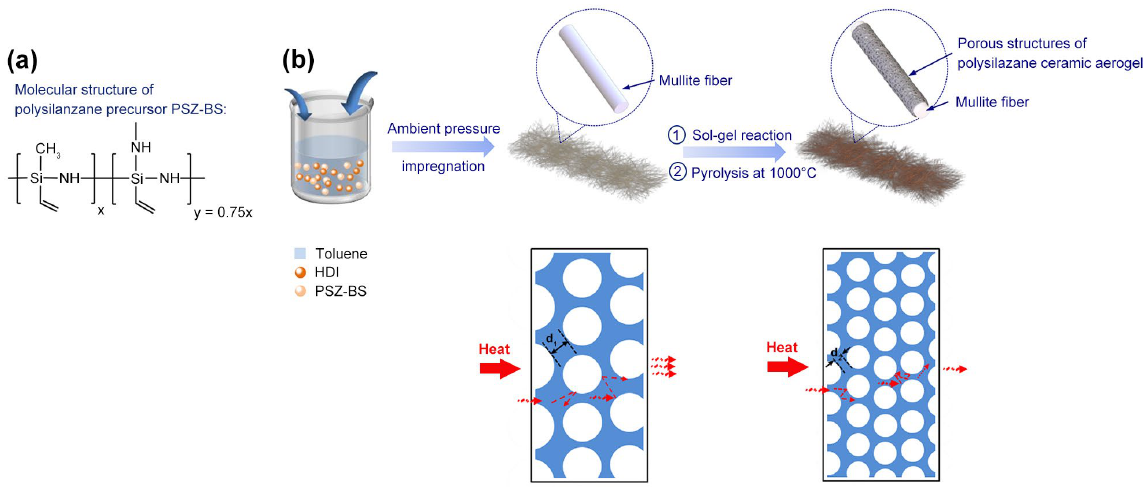
Figure 1. ( a ) Molecular structure of polysilazane precursor PSZ-BS, ( b ) schematic description of the preparation route of ceramic aerogel composite with low thermal conductivity based on reducing the pore size (d 2 < d 1 ) of the composite by compounding with the aerogel structure.